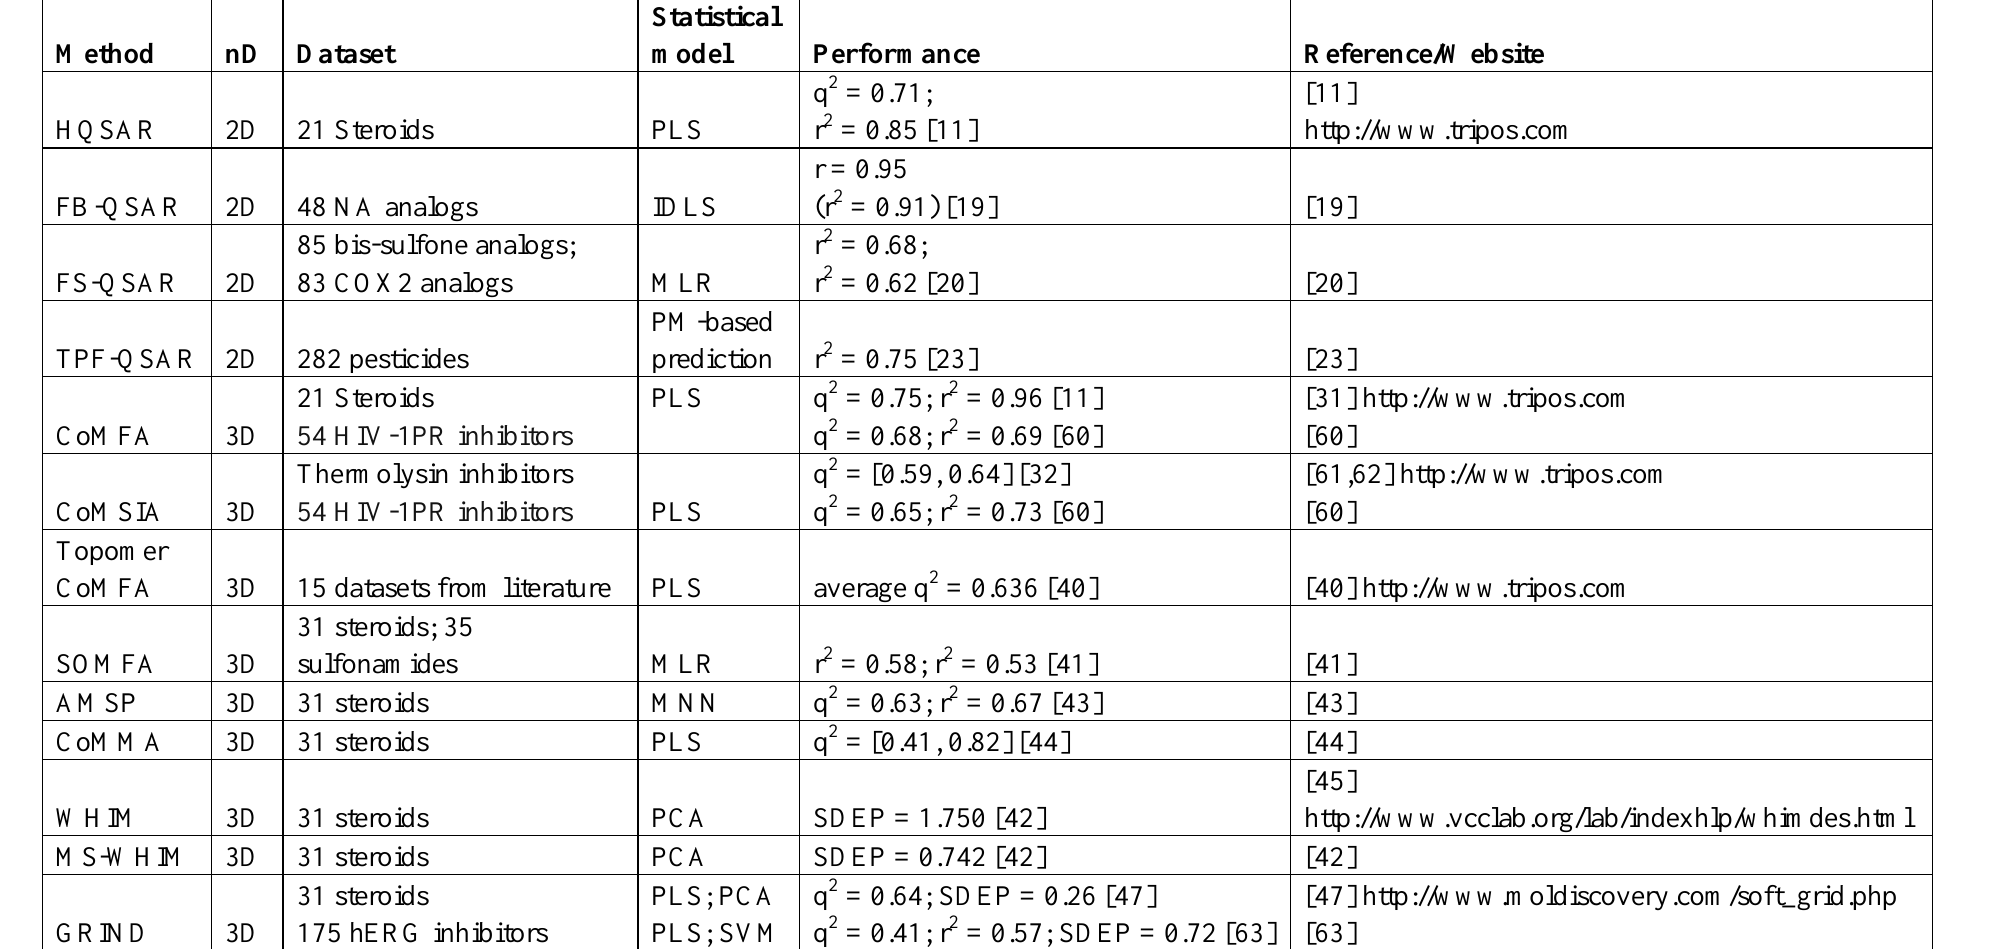
Table 1. Summary of different QSAR methods and source